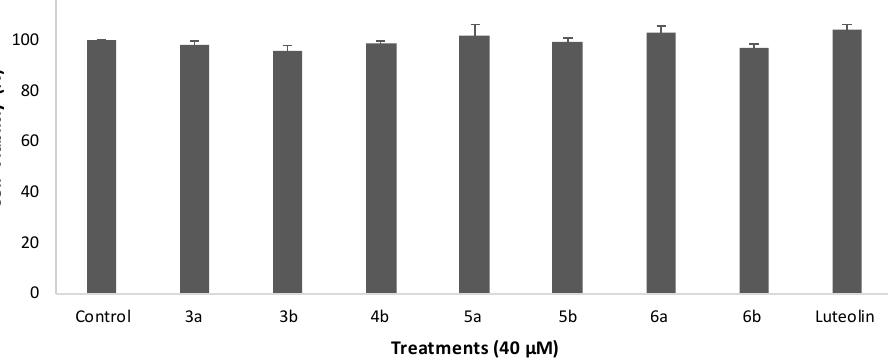
Figure 1. Cell viability of HUVECs at 40 µ M of tested flavones. Data are expressed as mean ± standard error of the mean (SEM), n = 3.